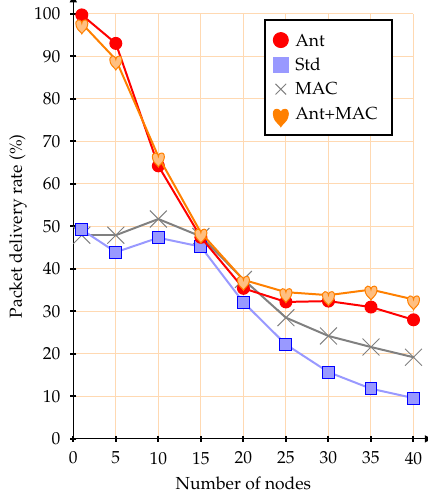
Figure 7. Average packet delivery rate at 1.4